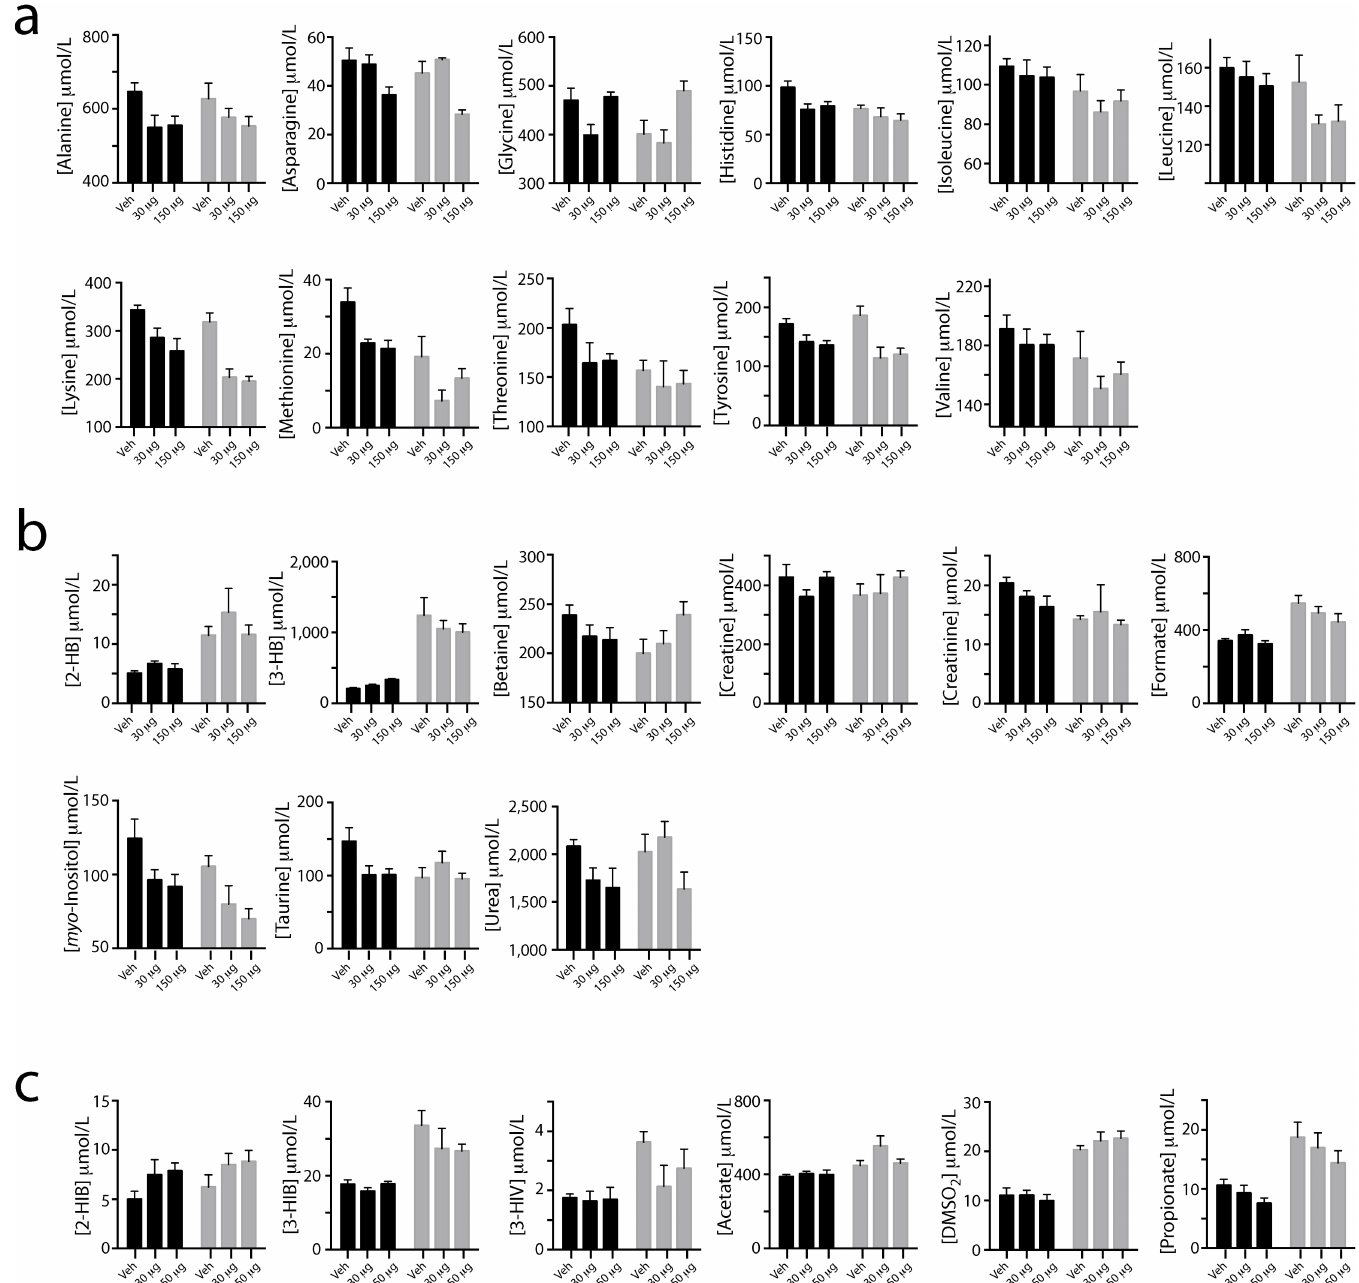
Fig 4. Plasmametabolite concentrations. Metaboliteconcentrations (mean ± SEM) in normal(black) and growth-restricted (grey) rats as a function of iron supplementation (Veh, 30 μ g, or 150 μ g per day). ( a ) Plasma amino acids. ( b ) Other plasma metabolites. ( c ) Metabolites of possiblemicrobialorigin. Abbreviations: 2-Hydroxybutyrate (2-HB); 3-Hydroxybutyrate (3-HB); 2-Hydroxyisobutyrate (2-HIB); 3-Hydroxyisobutyrate (3-HIB); 3-Hydroxyisovalerate (3-HIV), Dimethylsulfone (DMSO 2 ).